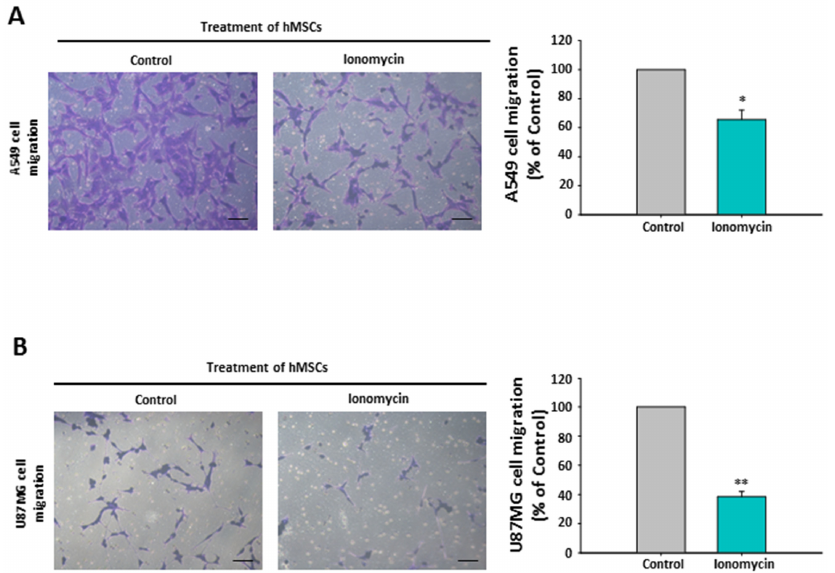
Figure 8. Effects of hMSC-conditioned media in the bottom chamber on A549 and U87MG cell migration in the transwell migration assay. Migration of A549 cells ( A ) and U87MG cell ( B ) toward hMSC-conditioned media. Left panel: representative images of the cell migration by crystal violet staining. Scale bar: 20 μ m. Right panel: quantification of the cell migration. Data are presented as the mean ± SEM of three independent experiments. * p < 0.05 and ** p < 0.01 as compared with Control.